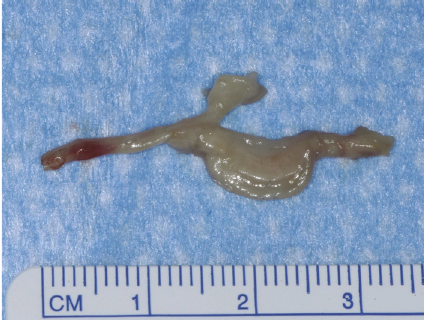
Figure 3: Excised interdigital nerve including a neuroma located distal to the bifurcation